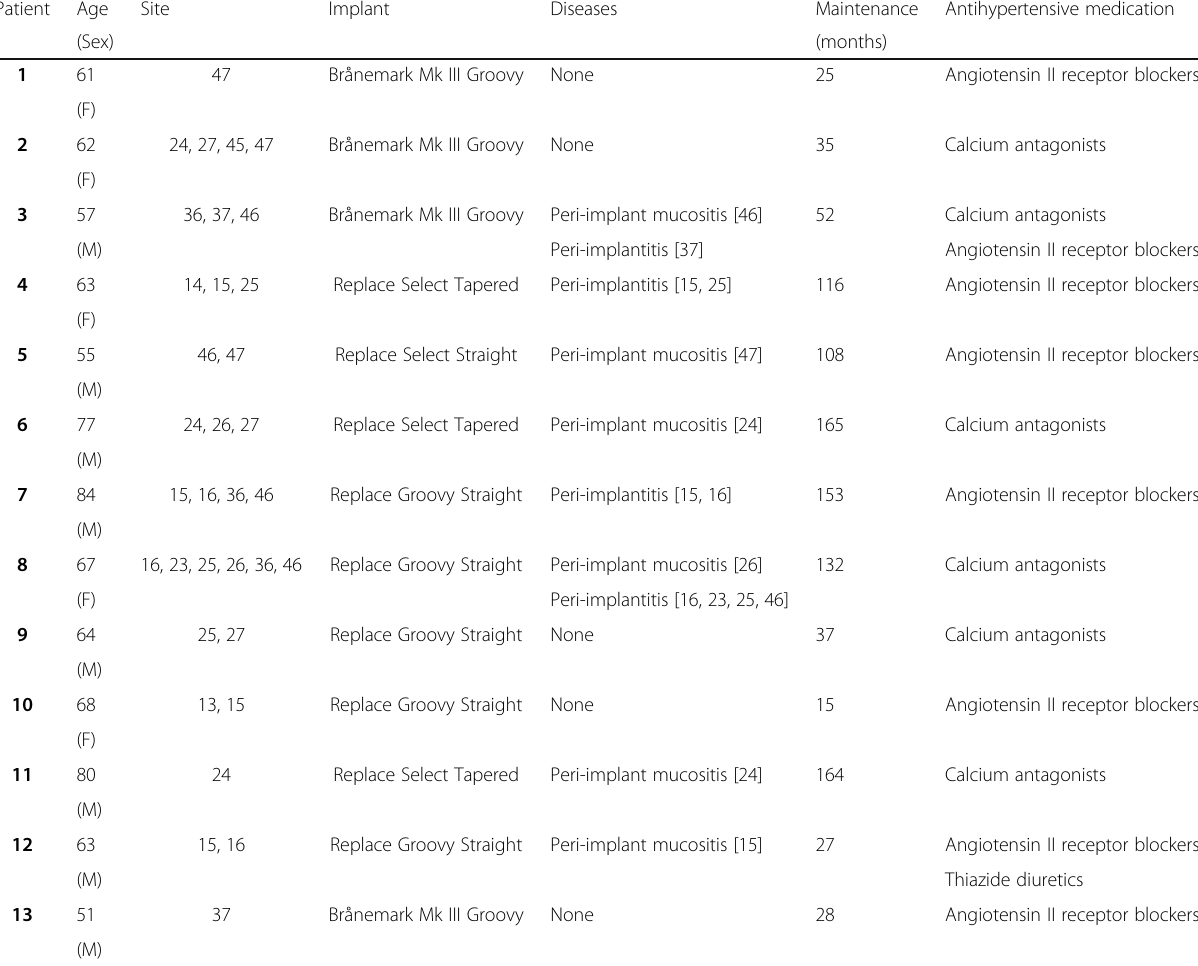
Table 2 Details of the patients in the AH group Patient Age